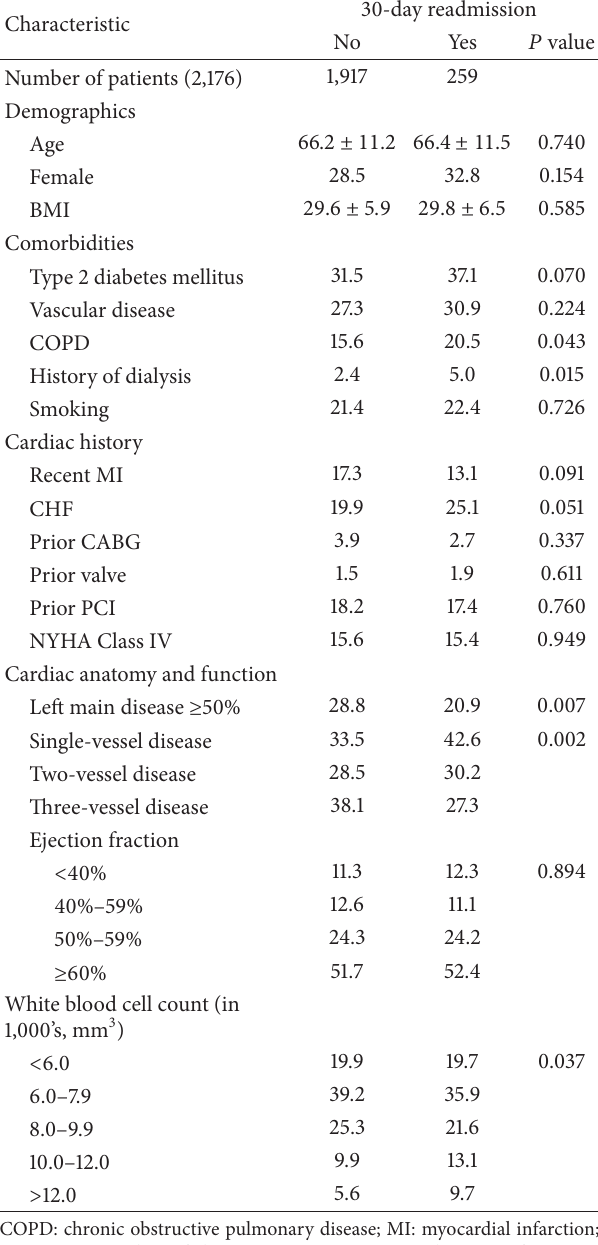
Table 1: Characteristics of patients with or without 30-day readmis-